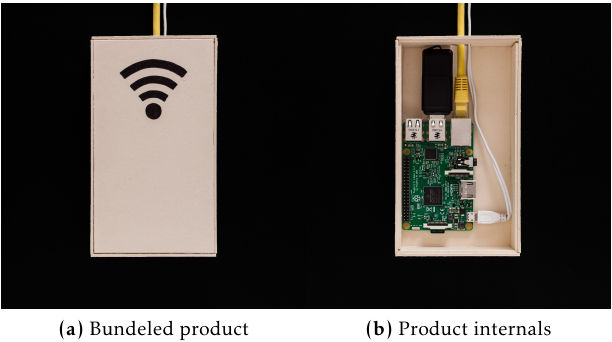
Figure 3. The final product: in the left is shown the bundled product, while in the right are shown its